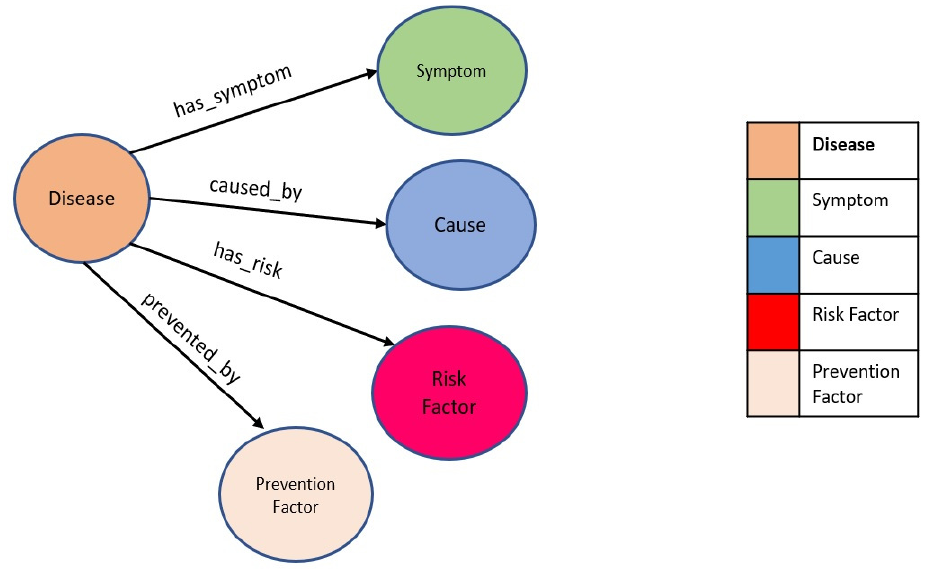
Figure 3. Phase 1 core RDF showing four relationships.